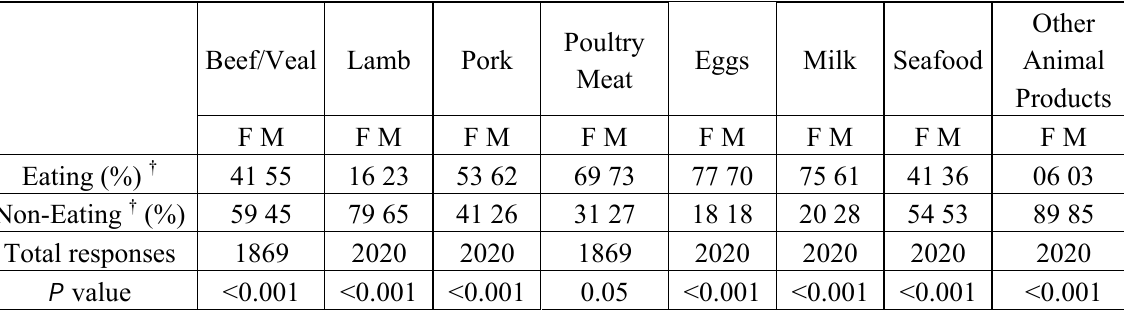
Table 8. Differences between male (M) and female (F) respondents in animal products that they used regularly.